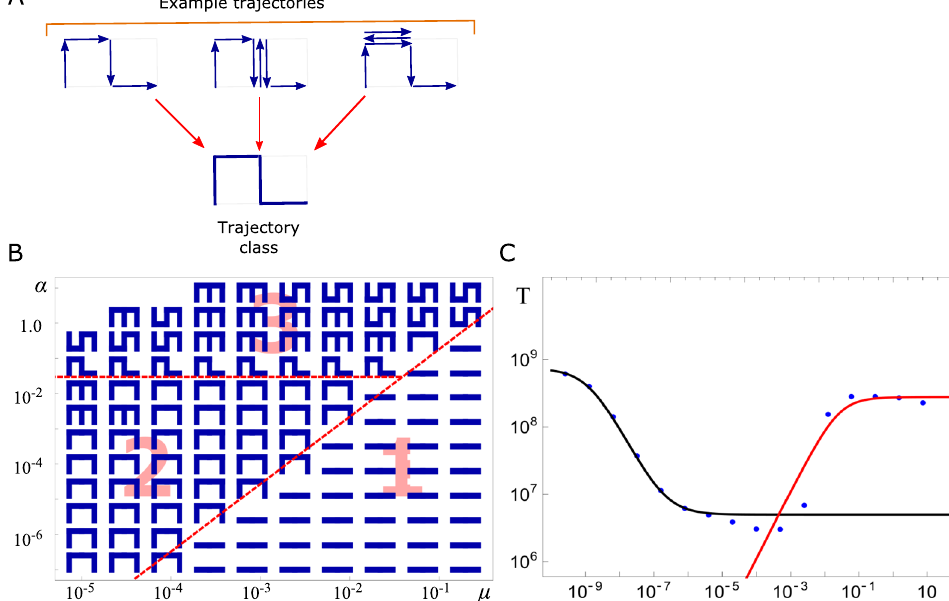
Figure 3. Trajectories of successful cells in genotype/phenotype space. ( A ) Diagram showing how different trajectories that go through the same set of states are grouped together into the same trajectory class. This class is represented as a symbol in which blue lines correspond to transitions made by the successful cell. ( B ) The most probable trajectory class as a function of μ and α , for K = 100, δ = 0.4 and d = 0.1. Three regions labelled 1, 2, 3 can be distinguished. ( C ) Comparison between analytic formula for the mean adaptation time (lines) and computer simulations (blue points). Parameters: K = 100, μ = 10 − 5 , d = 0.1, δ = 0.4. Black curve corresponds to T = T A T B /( T A + T B ) (see SI Sec. X for explanation) with T A given by Eq. (1) and T B by Eq. (2). Red curve is from Eq.